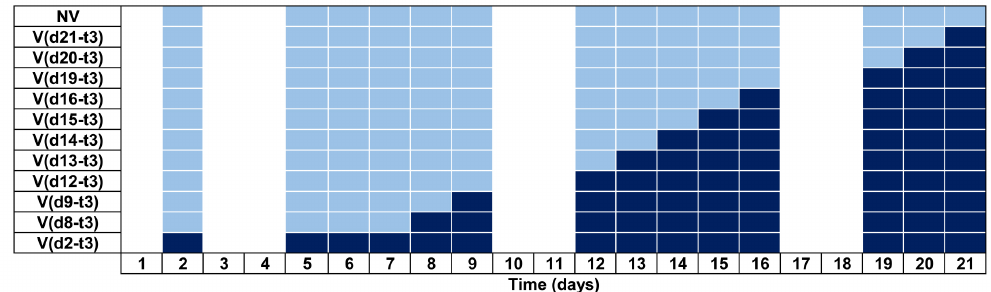
Figure 5. Timeline Experiment: Habituation experiment. The white squares are days with no data acquisition, the light blue squares were inspected without vibration ( t = 0 s) and the dark blue ones for 3 s ( t = 3). It represents the vibration application (dark blue squares) during the lifespan per condition.